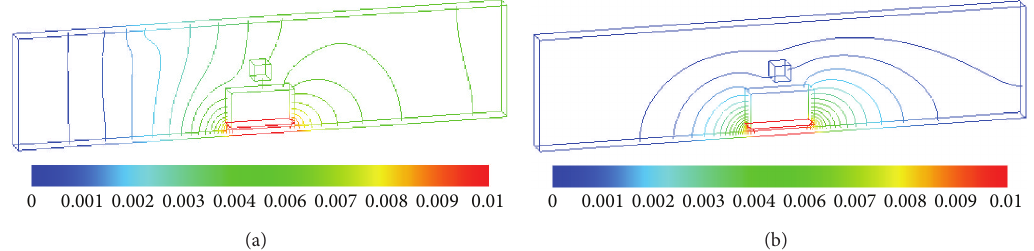
Figure 12: Isolines of contaminants concentration. (a) Without vertical external air; (b) with vertical external air.